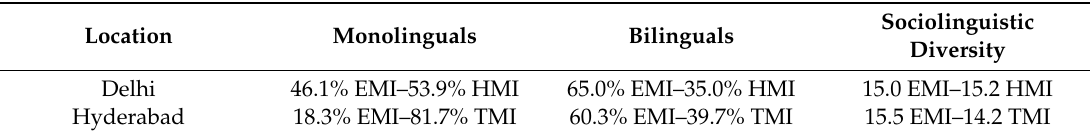
Table 3. Overview of the percentage of monolingual and bilingual children in either English or regional language-medium of instruction schools (children in EMI (English Medium of Instruction), HMI (Hindi Medium of Instruction), and TMI (Telugu Medium of Instruction)